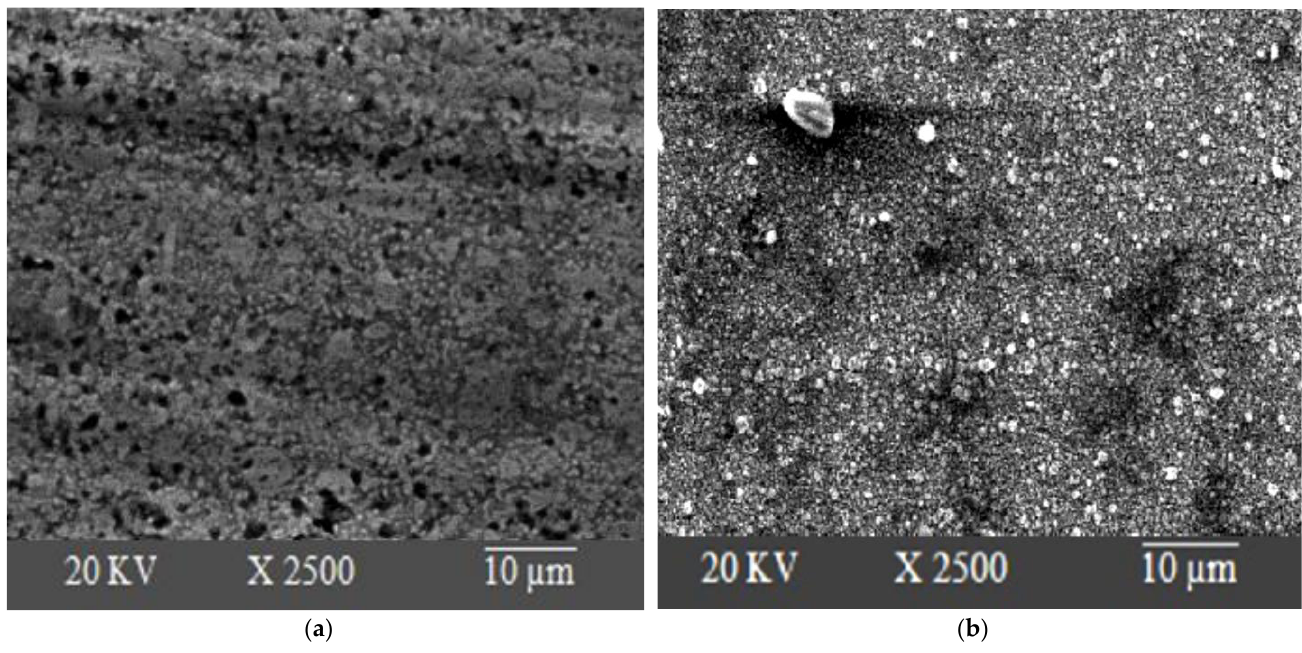
Figure 8. ( a ) SEM for pure aluminum in 1 M HCl in the absence of inhibitor; ( b ) SEM for pure aluminum in 1 M HCl in the presence of honey inhibitor.